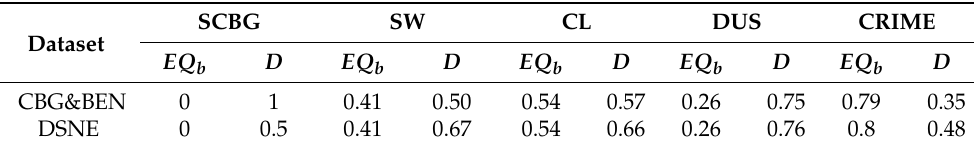
Table 6. DSNE algorithm and CBG&BEN algorithm are compared to use EQ b and D as evaluation index on different